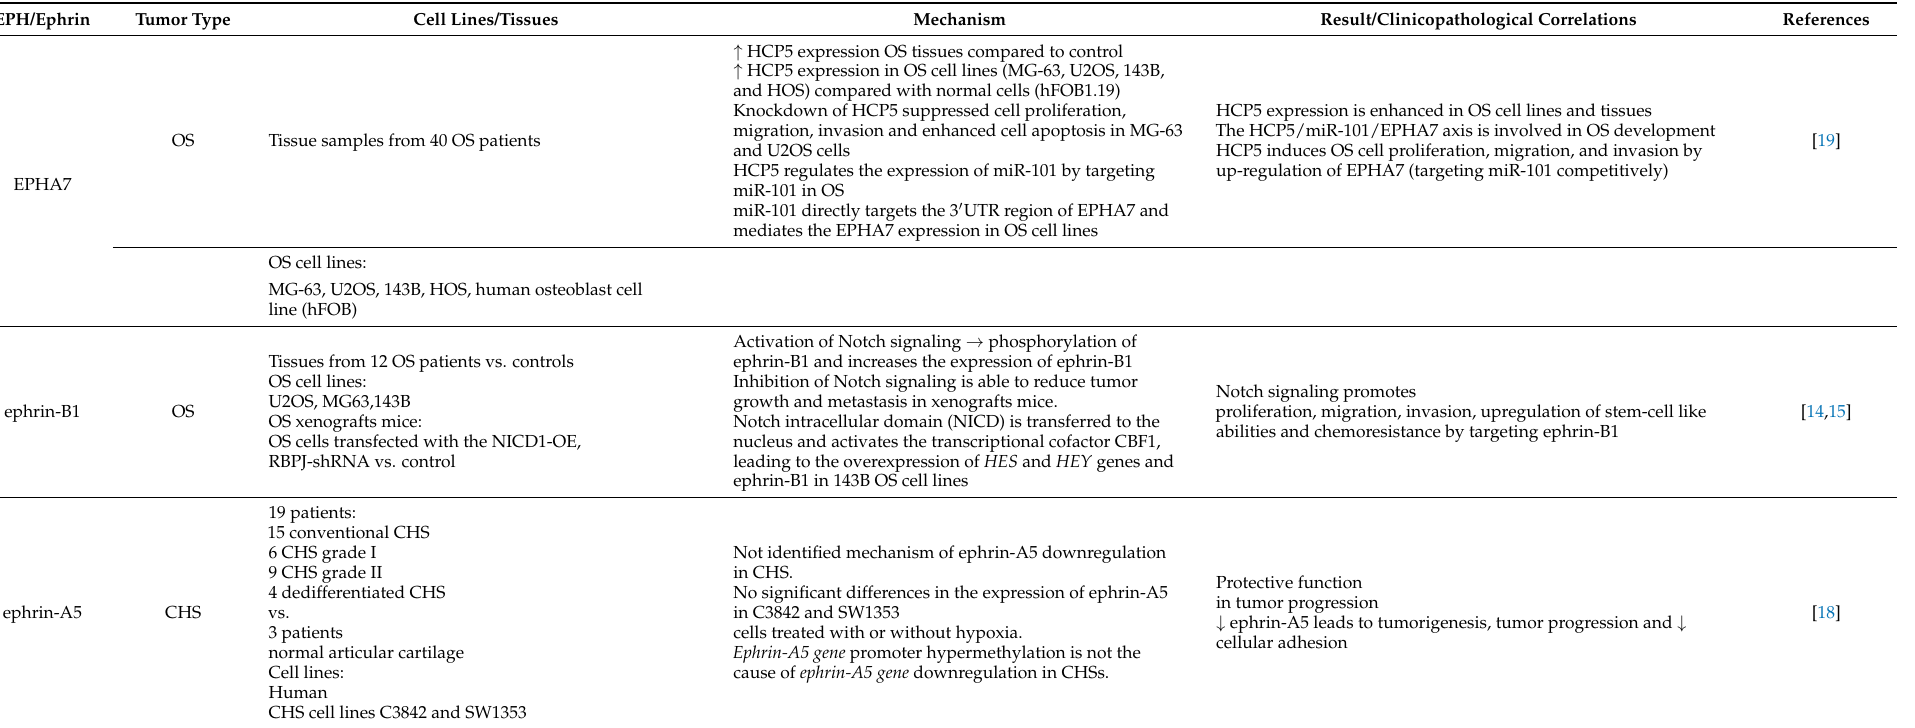
Tissue samples from 40 OS patients